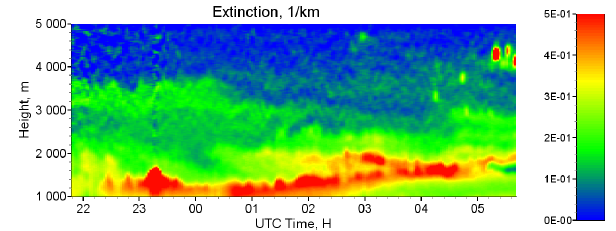
Figure 16. Aerosol extinction at 355nm on 27–28 August.